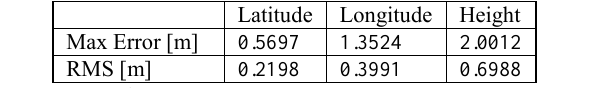
Table 3. Accuracy of WorldView-2 Stereo Image Covering Munich Test Field